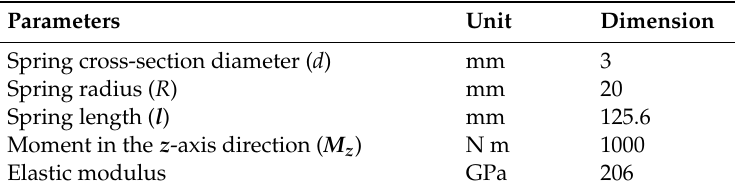
Figure 2. Finite-element model of torsion spring. Table 1. Design parameters.